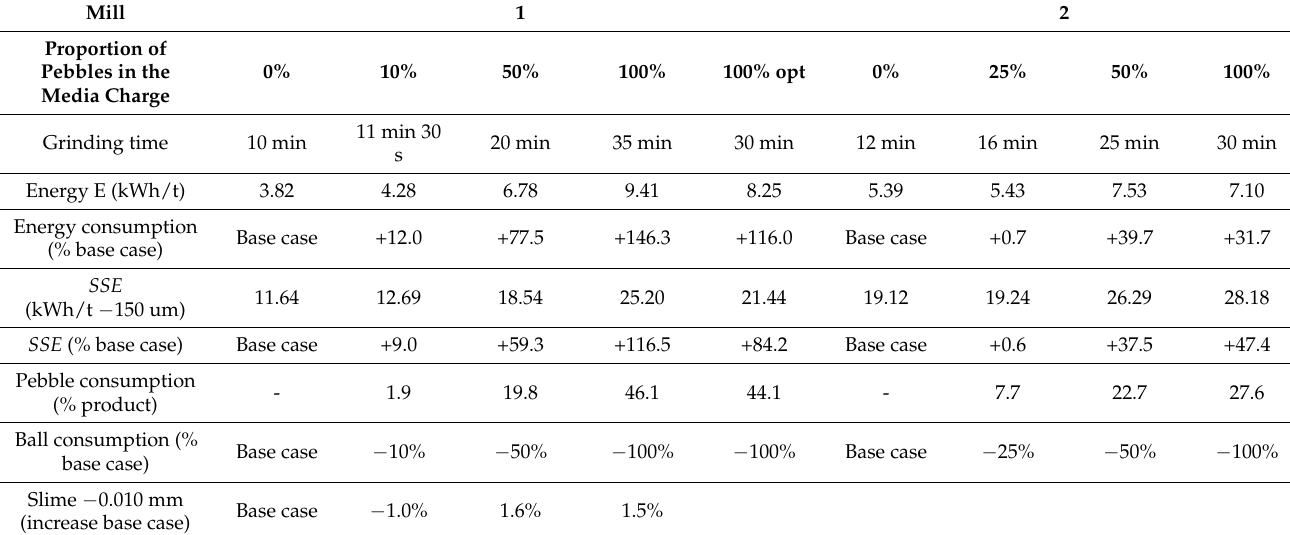
Table 6. Secondary grinding test